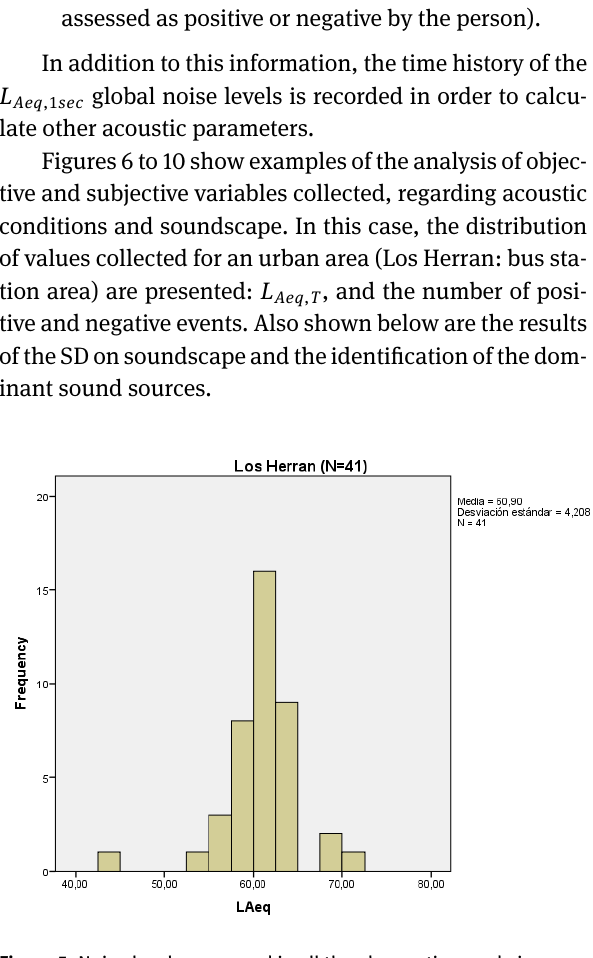
Figure 5: Noise levels measured in all the observation made in one place. A total of 41 observations were